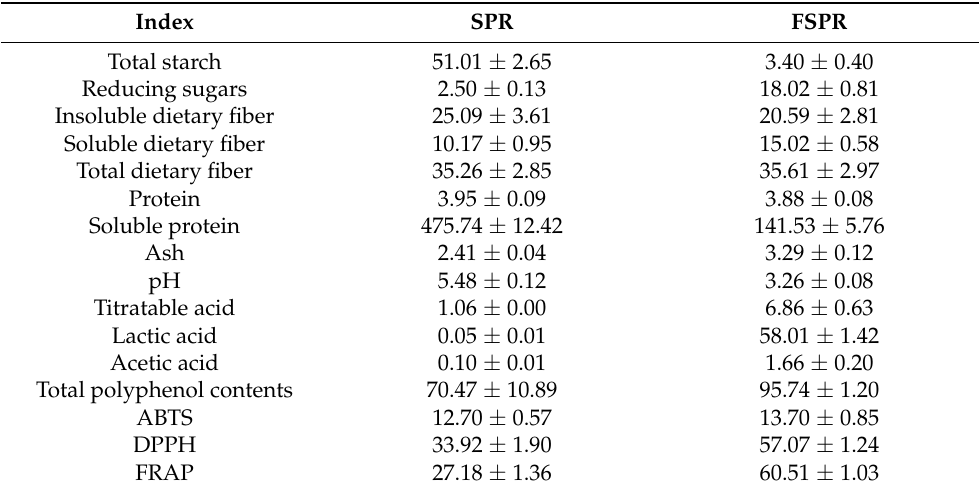
Table 1. Nutritional composition, pH, titratable acid, organic acids, total polyphenol contents, and antioxidant activities of sweet potato residues fermented with combined